Question: Looking at the figure, what chart type is it?
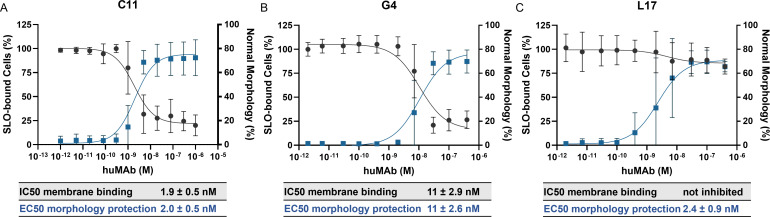
Answer: line